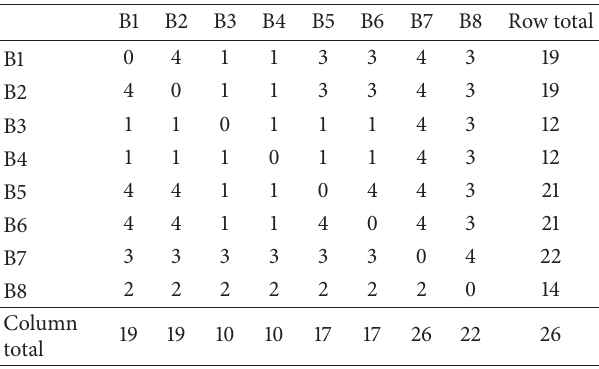
Table 7: The average matrix of model 2.